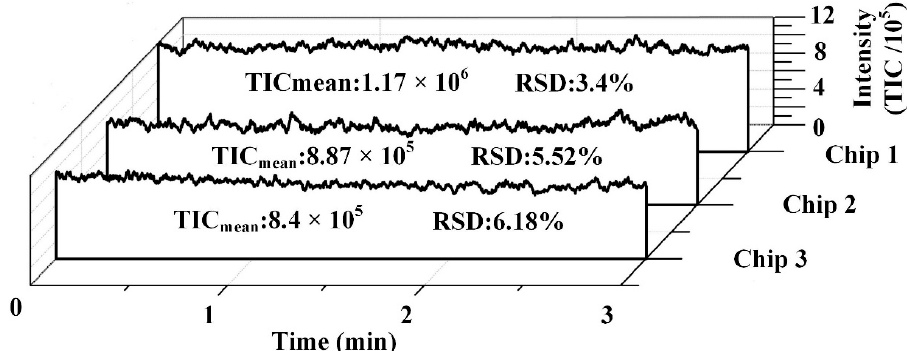
Figure 8. The batch-to-batch reproducibility of three chips. The conditions for three chips were the same: 41.5 μ M Reserpine in 3/1 ( v / v ) methanol/water with 0.2% formic acid, the gas pressures for the liquid channel and air channel were about 250 and 300 mbar, respectively, and the high voltage added on the liquid channel was 5 kV. TIC mass range from 550 to 850.